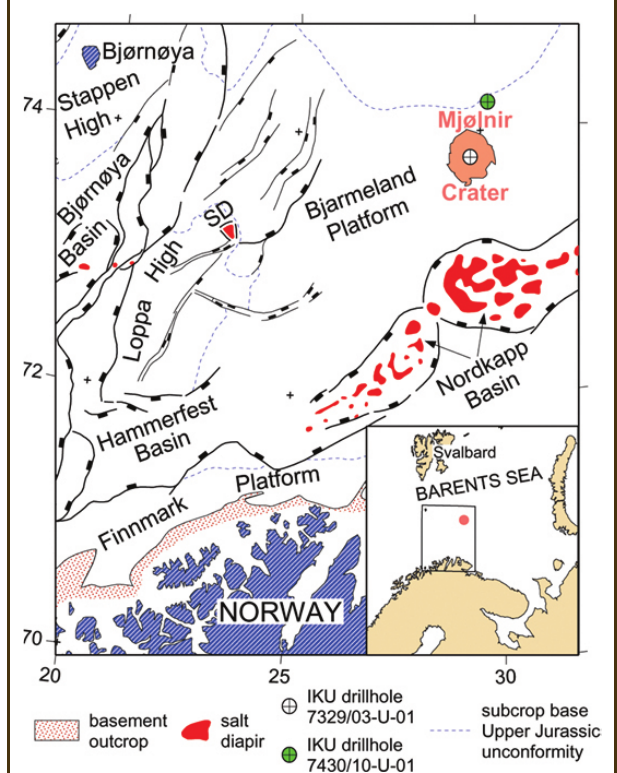
Figure 1. A tectonic map of the Bjarmeland Platform area in the Barents Sea, with a regional inset showing the Mjølnir and Svalbard position. The Mjølnir impact crater location and key shallow drillholes are shown in the main